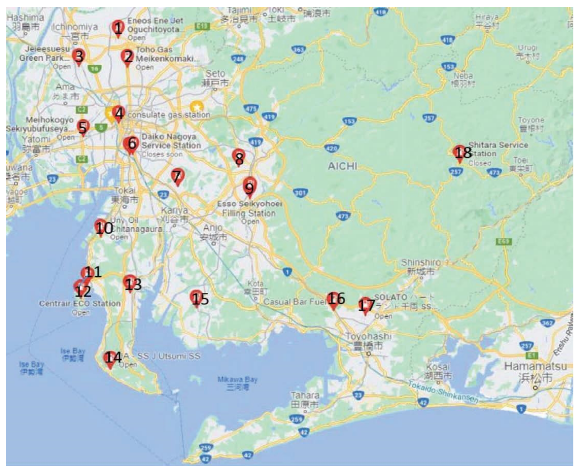
Figure 1: Proposed EVCS location (Google Map).